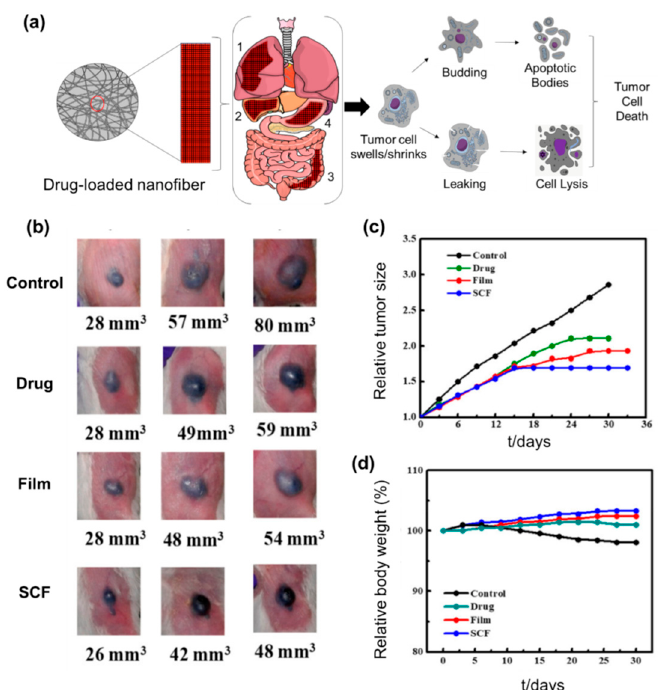
Figure 3. ( a ) The cytotoxicity effects of anticancer drug-loaded electrospun nanofibers targeting various deadly cancers. (Here, the numerical numbers 1, 2, 3, and 4 on the diagram represent the usages of nanofibers in lung, liver, gastric and colon cancer respectively.); ( b ) tumor dimension after treating with indicated patches (DXM-PLA); ( c ) quantitative tumor volume of mice treated with indicated scaffold/film/drug/control; ( d ) change of body weight of mice as a function of time upon treatment with indicated patch (Figure 3b–d reproduced from ref. [65] with permission from ACS Publication, 2019).